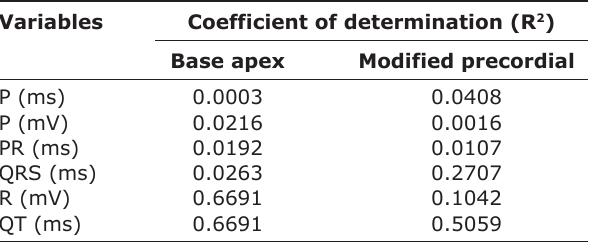
Table-3: Coefficient of determination (R 2 ) between base apex and modified precordial lead system. Variables